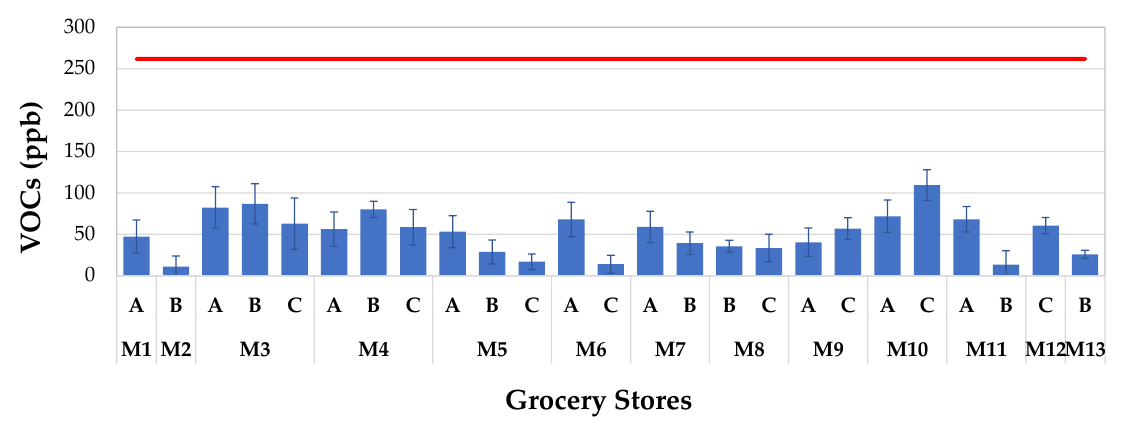
Figure 5. VOC levels assessed in all locations of the studied GSs. The red line represents the limit value of 262 ppb established by Portuguese legislation [34].